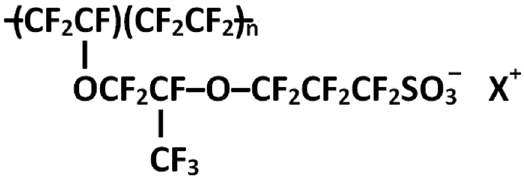
Figure 1. Structural formula of Nafion. X + is the representation of the counter